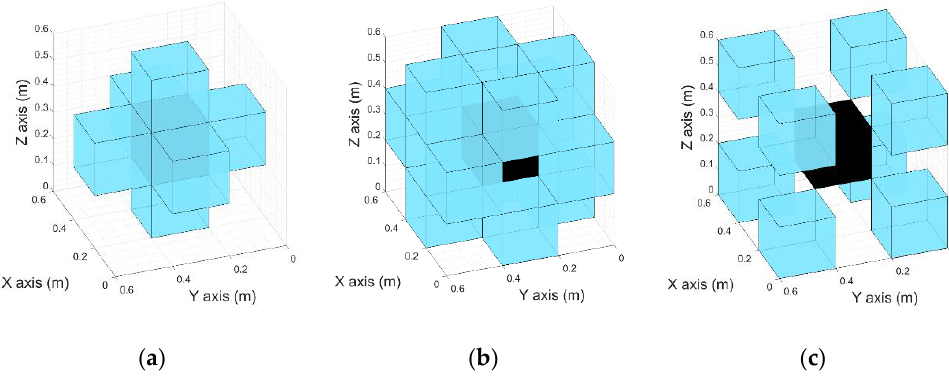
Figure 12. Different relations between voxels (black: Study voxel. Blue: Surrounding voxels). ( a ) Common face. ( b ) Common edge. ( c ) Common vertex.